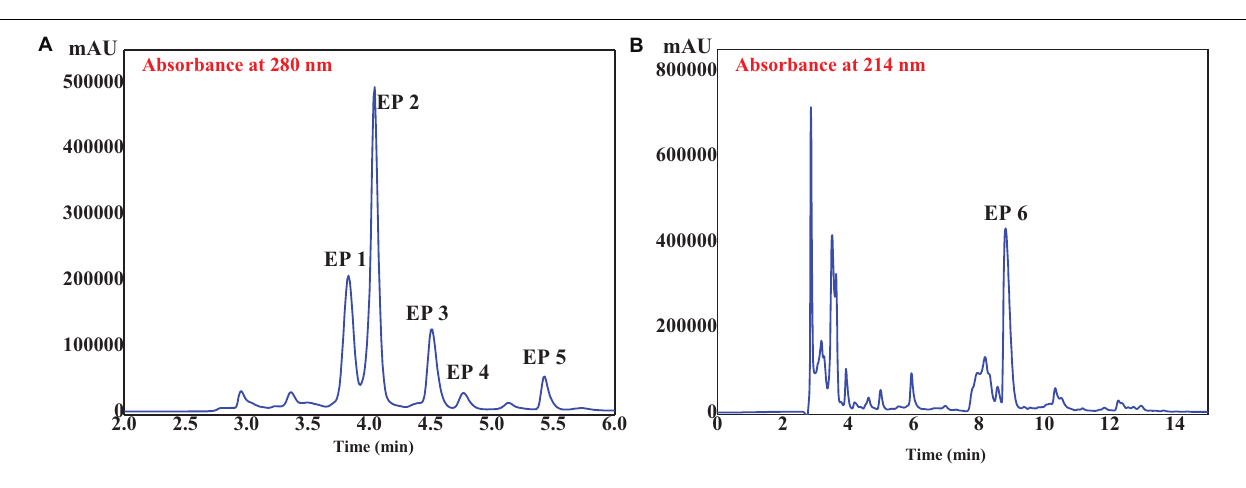
FIGURE 4 | Elution profile of ZD60-I in Sephadex G-25 chromatography (A) and the DPPH · scavenging rates of four subfractions (GD-I to GD-IV) from ZD60-I at the concentration of 10 mg/ml, respectively (B) . All data were presented as the mean ± SD ( n = 3). a - d Values with the different letters indicate a significant difference ( p < 0.05).